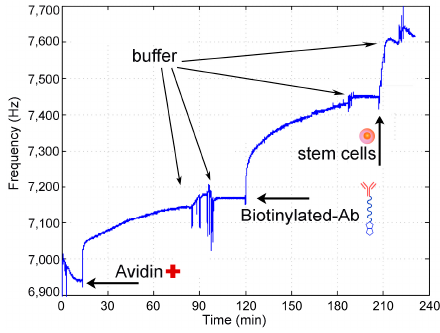
Figure 6. Frequency shift measurements in the QCM immunosensor for stem cell detection.